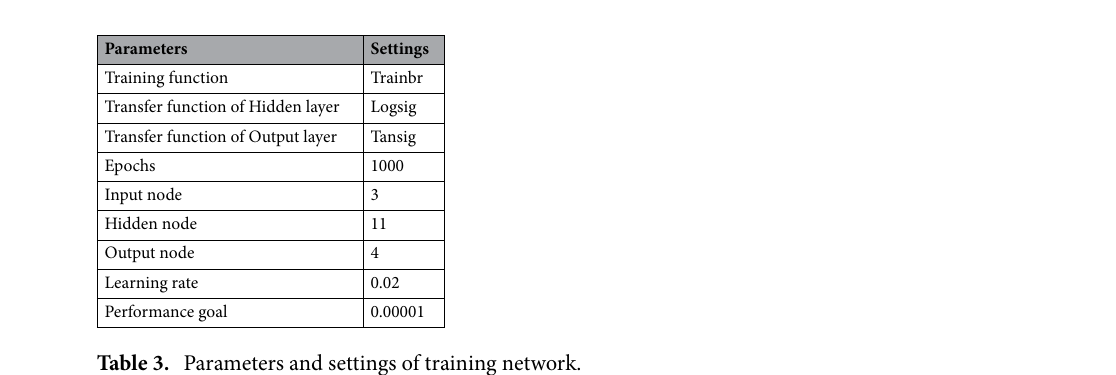
Table 3. Parameters and settings of training network.